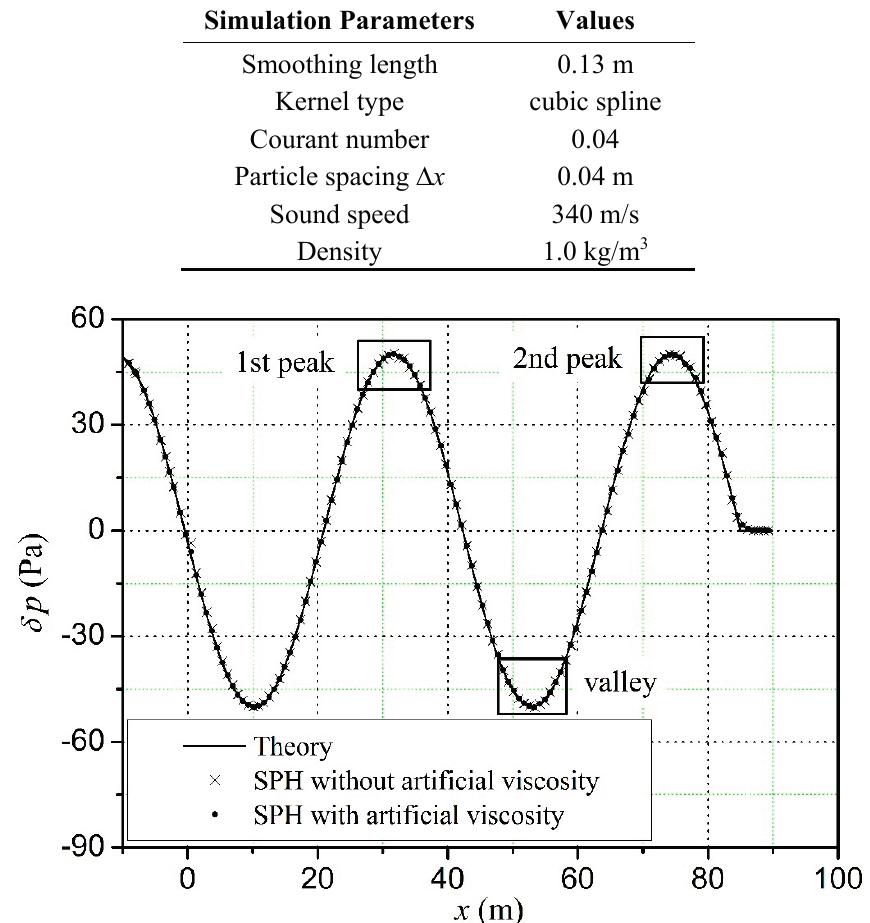
Table 1. Parameters for the SPH algorithms of sound propagation and interference.